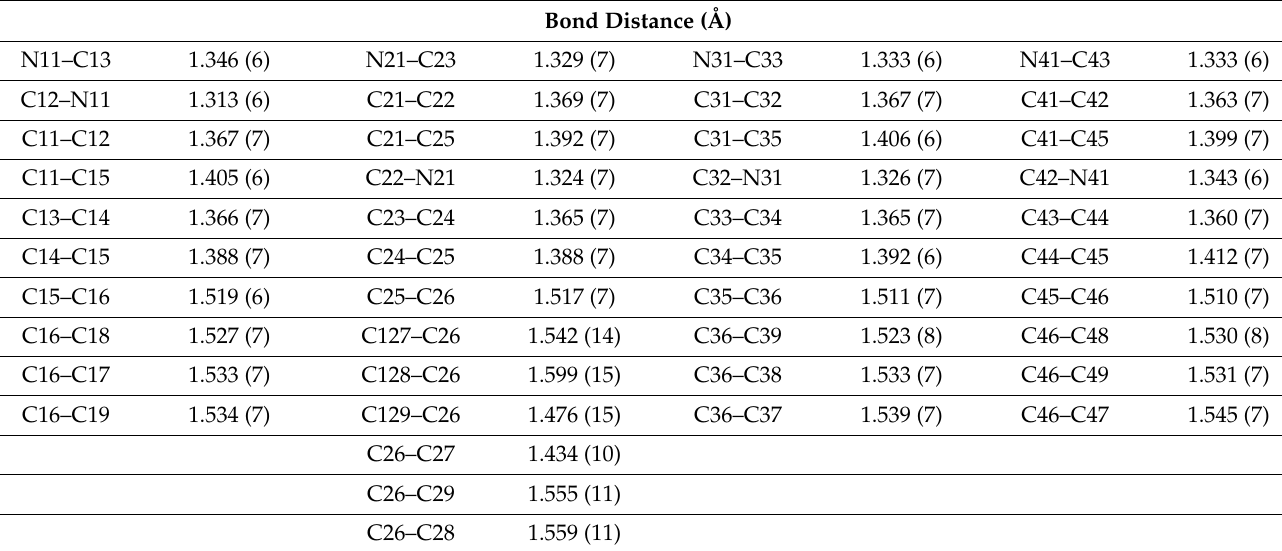
Table 4. The basic geometrical properties of 4-ter-butyl-pyridinium in (C 9 H 14 N) 2 [CuCl 4